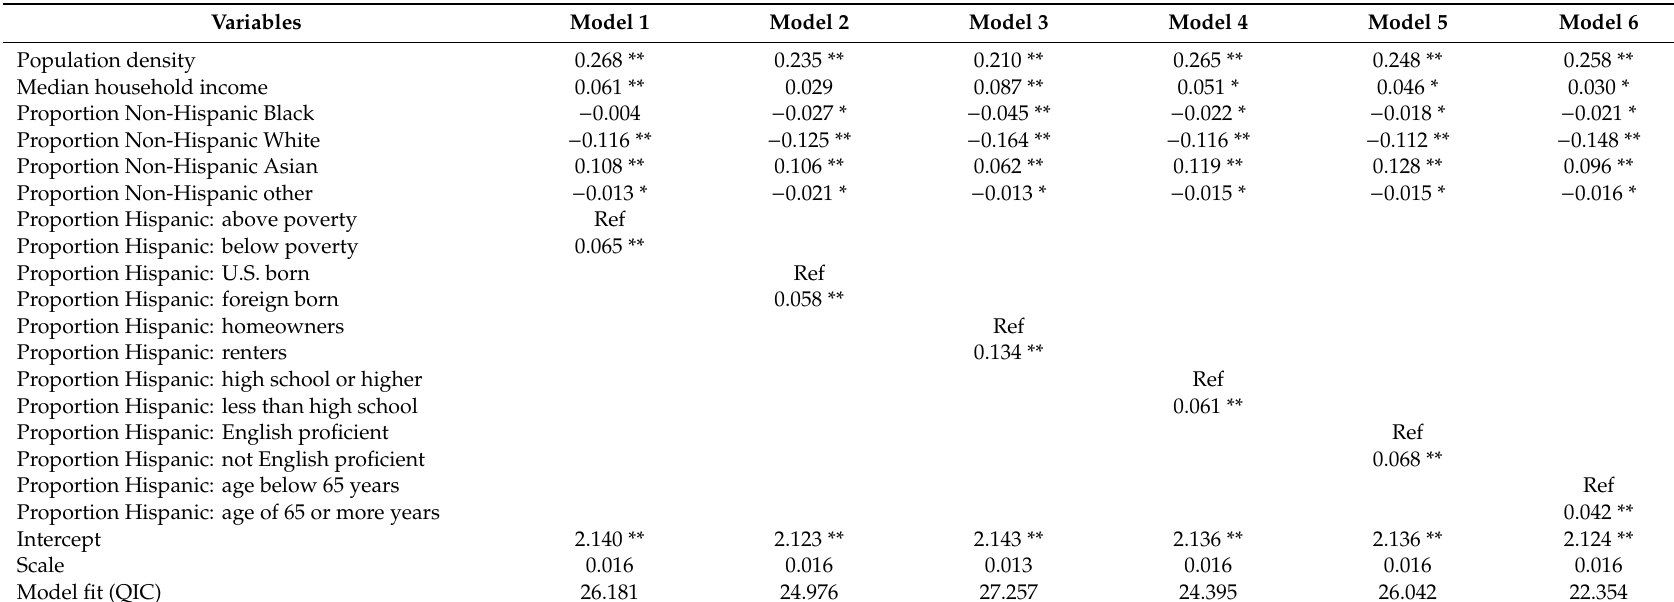
Table 4. Intra-categorical GEE analysis for the Hispanic population: Beta coe ffi